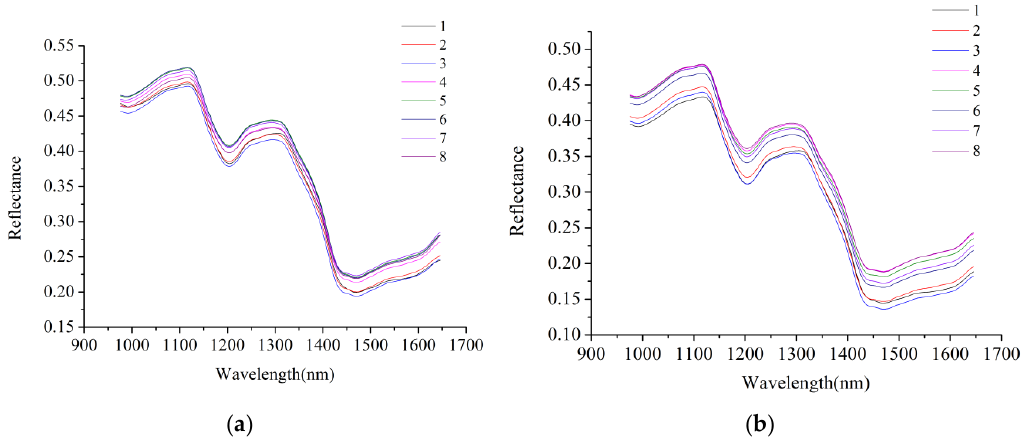
Figure 1. Average spectra of unprocessed spectra: ( a ) Maize 1; ( b ) Maize 2. Average spectra of maize kernels under different aging duration time differs in reflectance value.